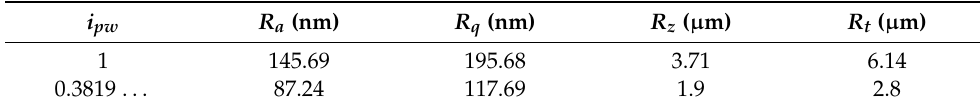
Table 2. Comparison between surface characteristics at i pw = 1 and i pw = 0.3819 . . . . i